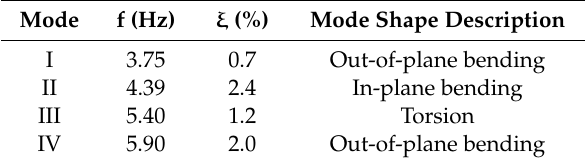
Table 3. Ufita bridge: output-only modal identification results.